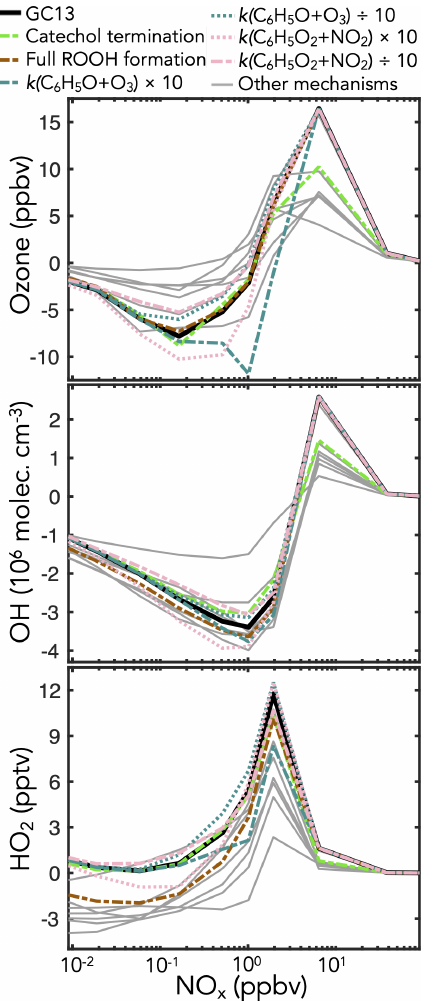
Figure 9. Sensitivity of midday ozone, OH, and HO 2 concentra- tions in the GC13 aromatic mechanism to changes in individual reaction rate constants and yields. The black lines show the stan- dard GC13 box model simulation for the effect of mixed aromatic emissions in the continental boundary layer at 10:00–14:00LT, rel- ative to a simulation with no aromatic emission. The colored and patterned lines show the effects of individual changes in the GC13 mechanism. Gray lines show the results from the other mechanisms in Table 1. Results shown for the GC13 standard simulation and other mechanisms are the same as for Fig. 8 except that BTX emis- sions were doubled to better show the changes from the individual